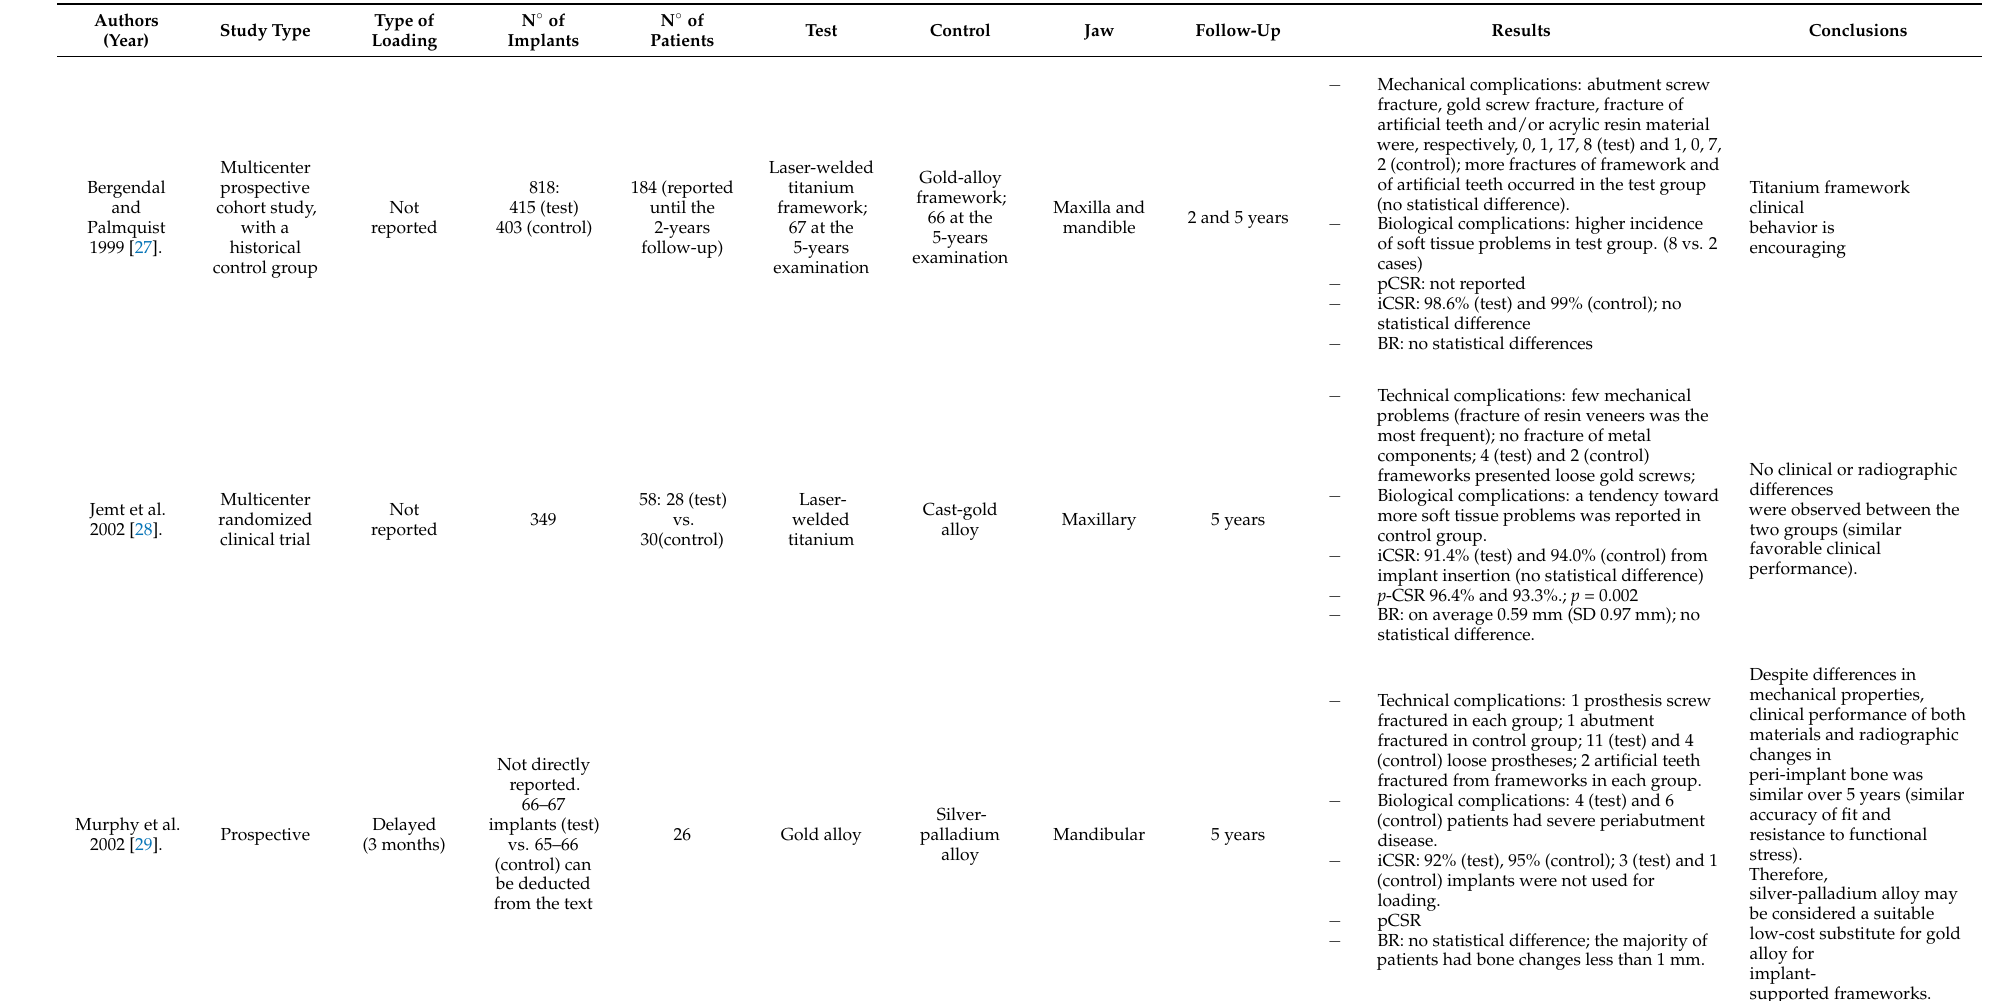
Table 1. Main characteristics and outcomes of the included